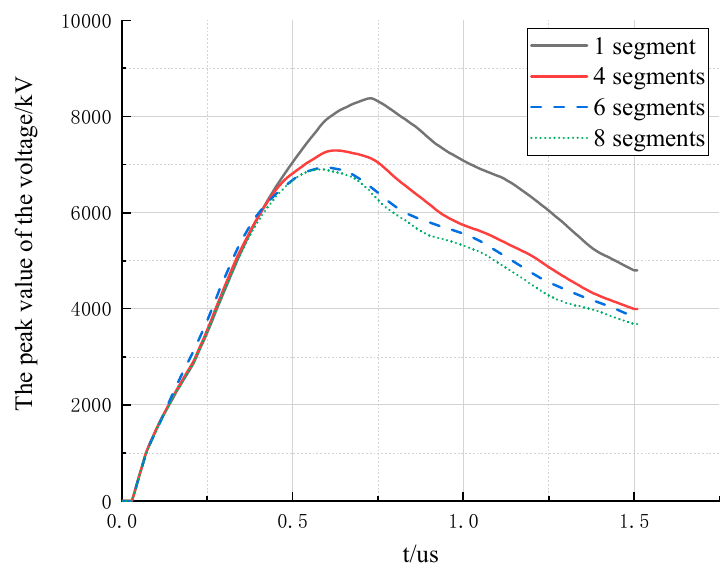
Figure 10. The peak value of the voltage for multi-segment multi-surge impedance model.